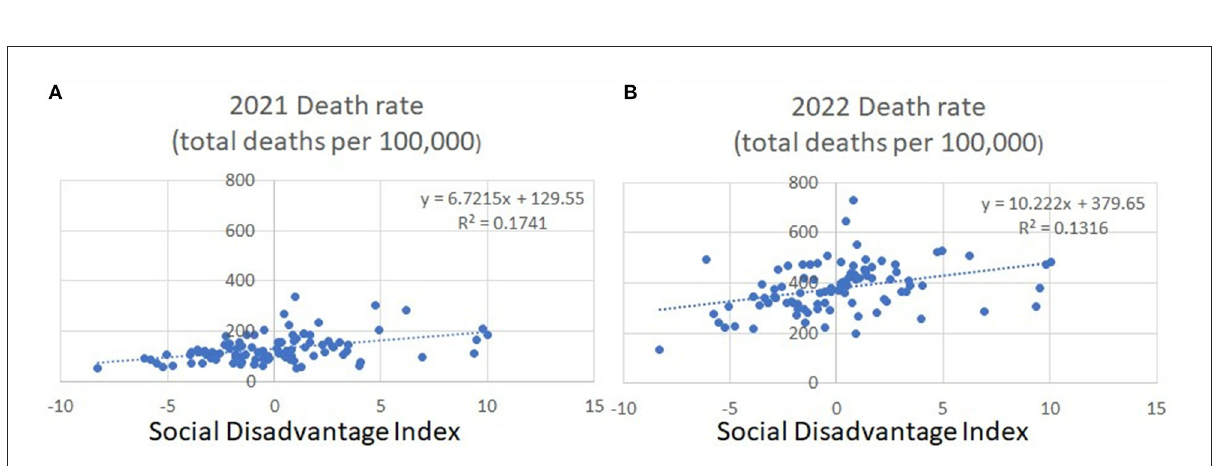
FIGURE7 Social disadvantage and death rates for (A) January 1, 2021; (B) January 1,